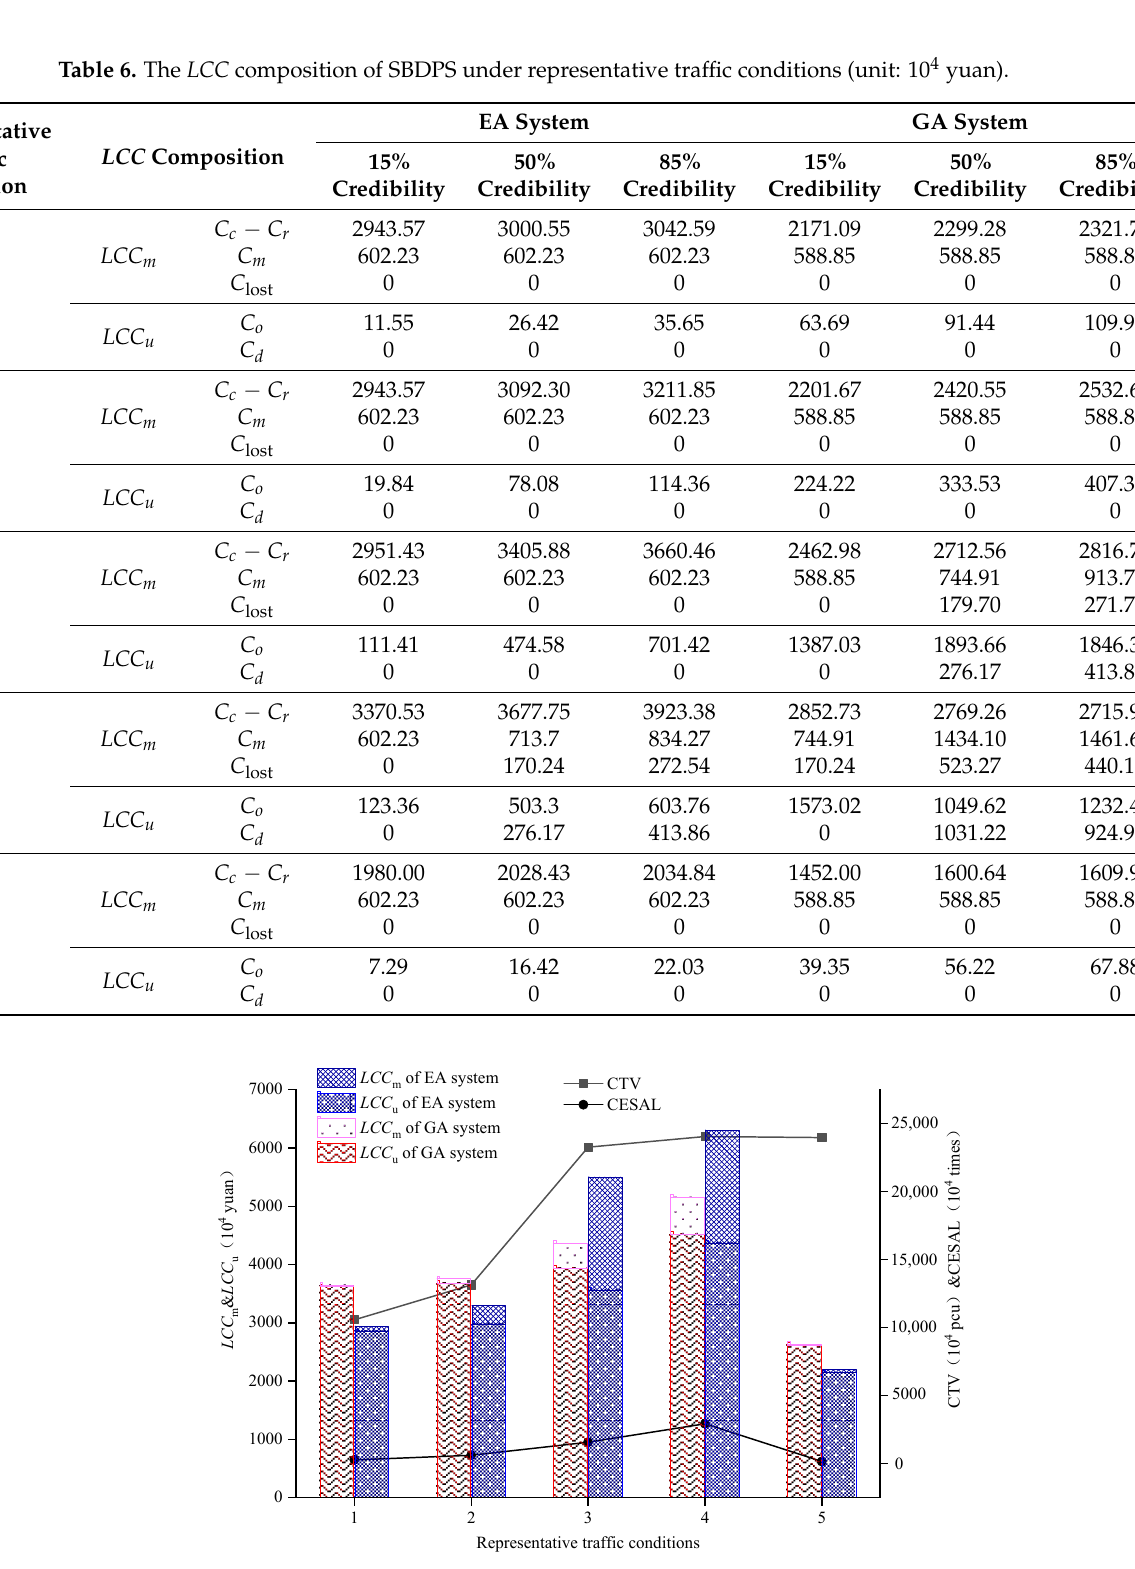
Figure 4. The LCC composition of SBDPS under representative traffic conditions: CESAL = cumulative equivalent single axle loads; CTV = cumulative traffic volume; LCC m = manager cost; LCC u = user cost; pcu = passenger car unit.